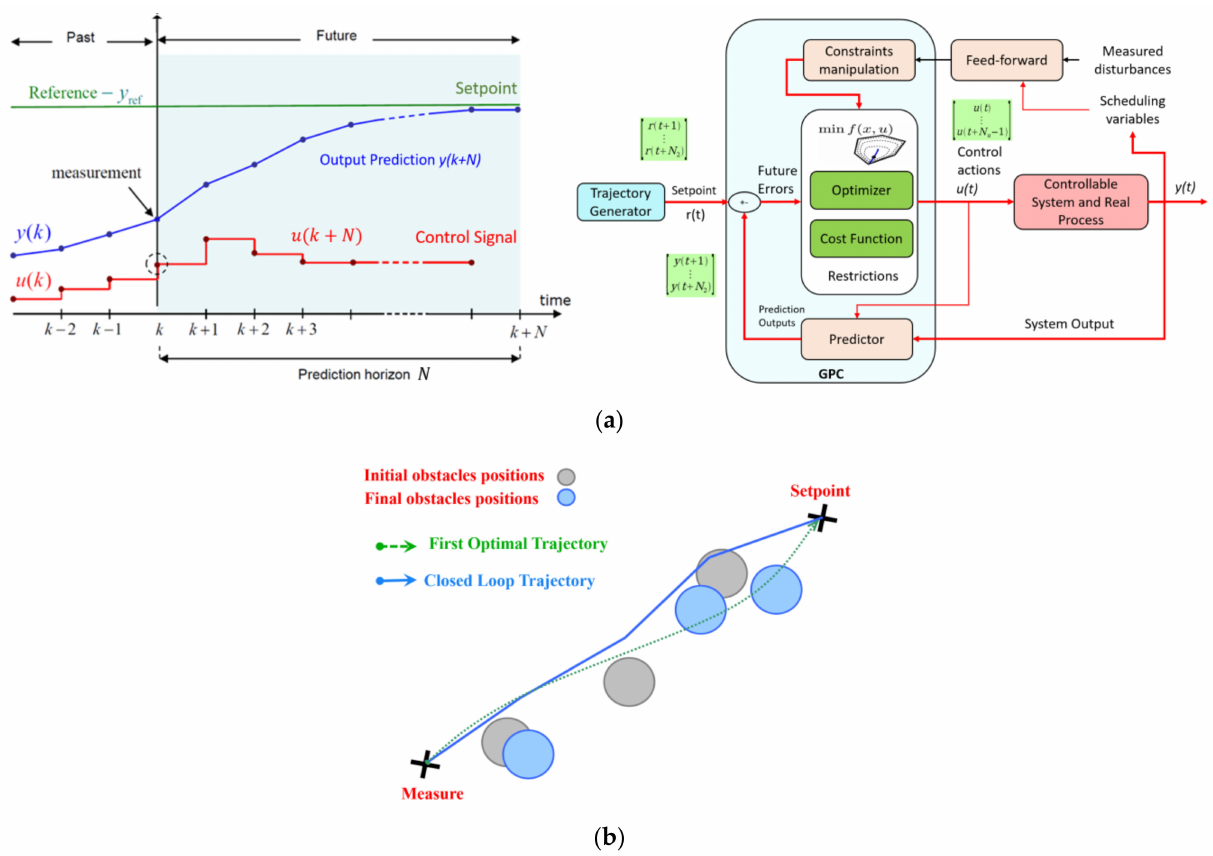
Figure 4. A schematic view of GPC concept: ( a ) control actions on the horizon N , ( b ) predictive control